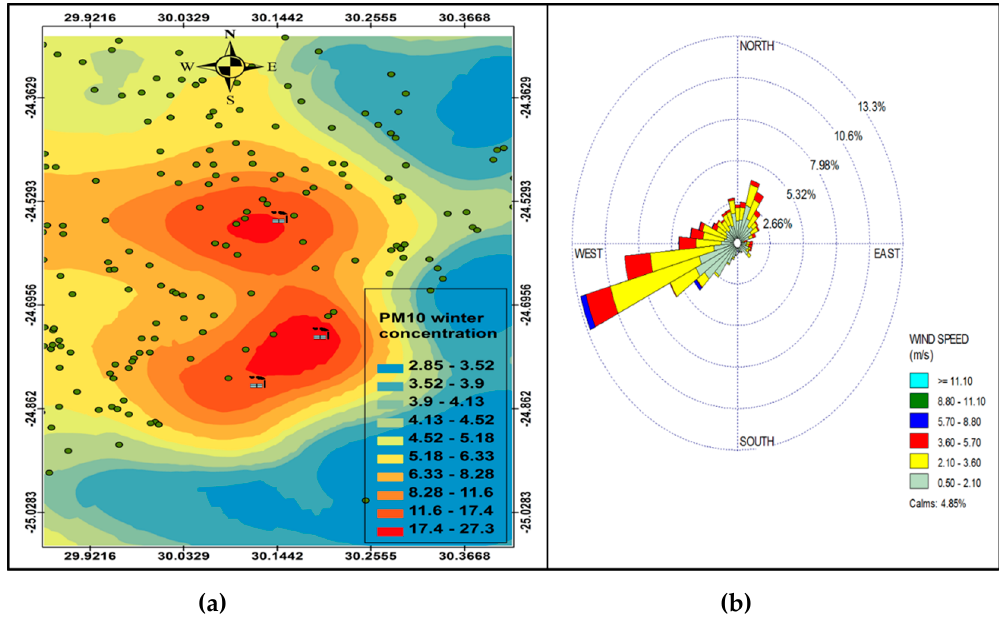
Figure 7. Winter variation in PM 10 (µg.cm − 3 ) ambient concentration ( a ) and wind roses ( b ).